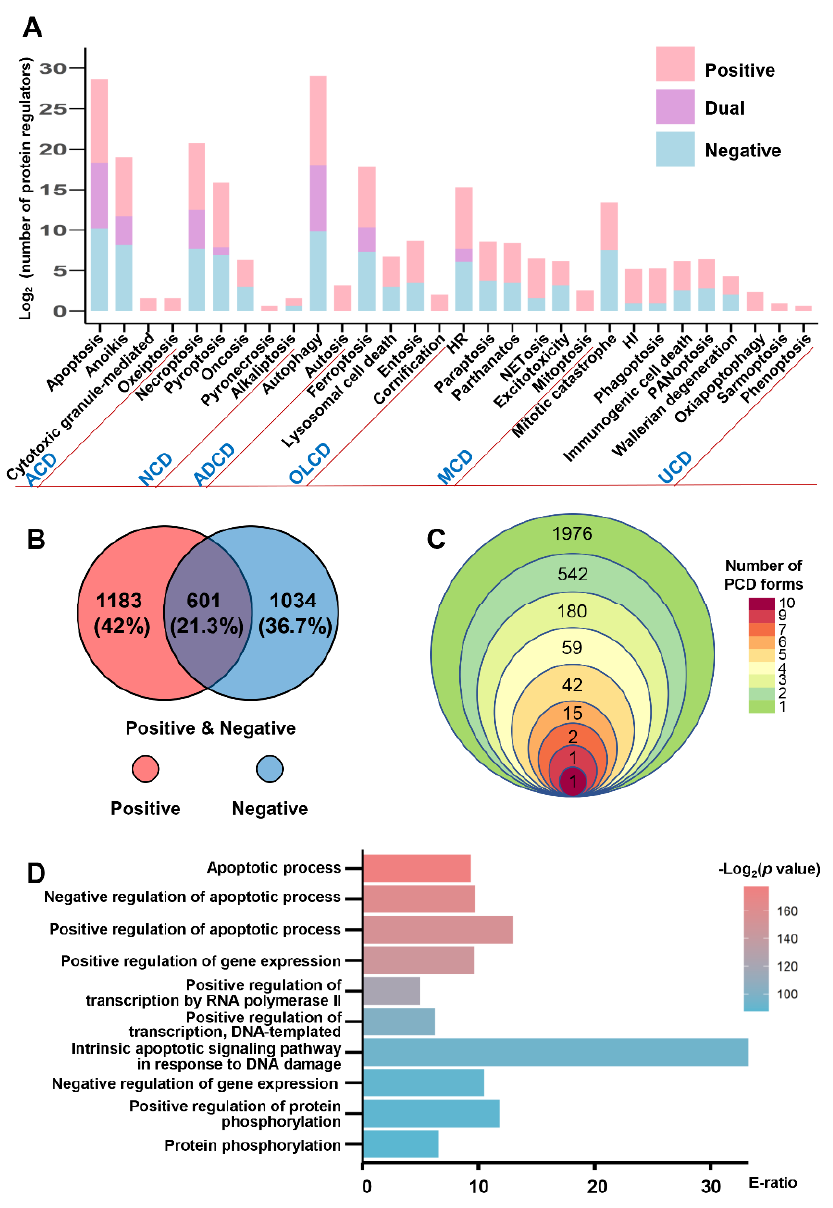
Figure 3. The data counts and analysis of PCD regulators in the iPCD. ( A ) The numbers of positive regulators (‘+’), negative regulators (‘−’) and dual regulators (‘+/−’) are separately presented for each PCD form. ( B ) The overlap of two types human PCD regulators. ( C ) The numbers of PCD regulators involved in different PCD forms. ( D ) The GO-based enrichment analysis of regulators involved in more than 2 PCD processes.